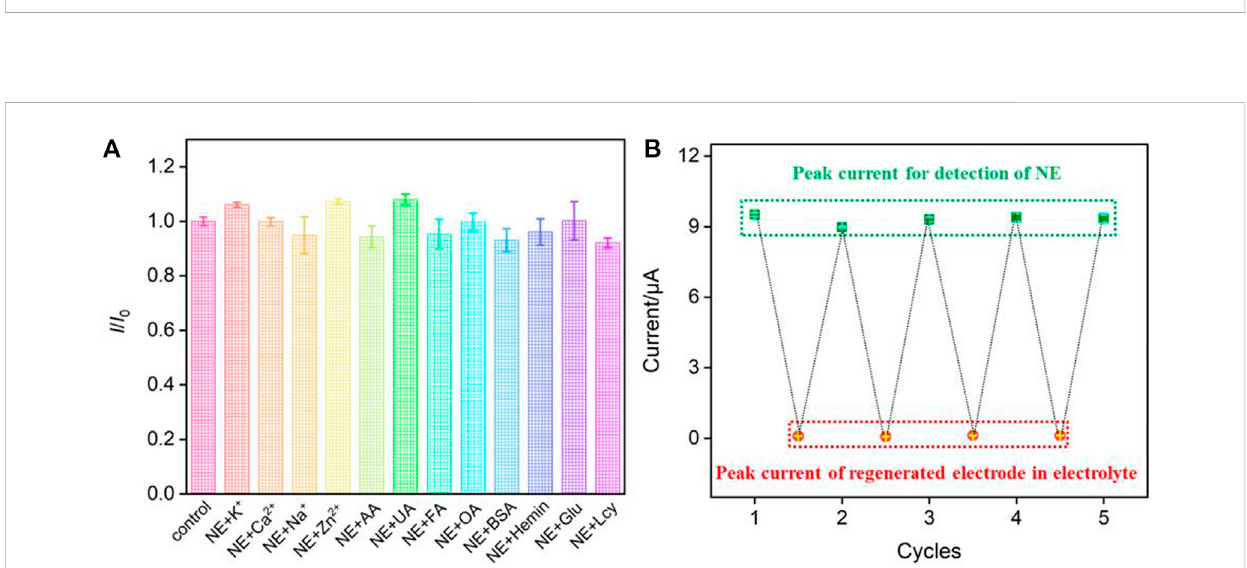
FIGURE 5 (A) DPV curves obtained on AuNPs@NH 2 -VMSF/p-GCE in presence of different concentrations of NE. Inset is the magni in the low-concentration region. (B) The calibration curve between the peak current and the concentration of NE. Inset is the magni fi ed view of low concentration region.